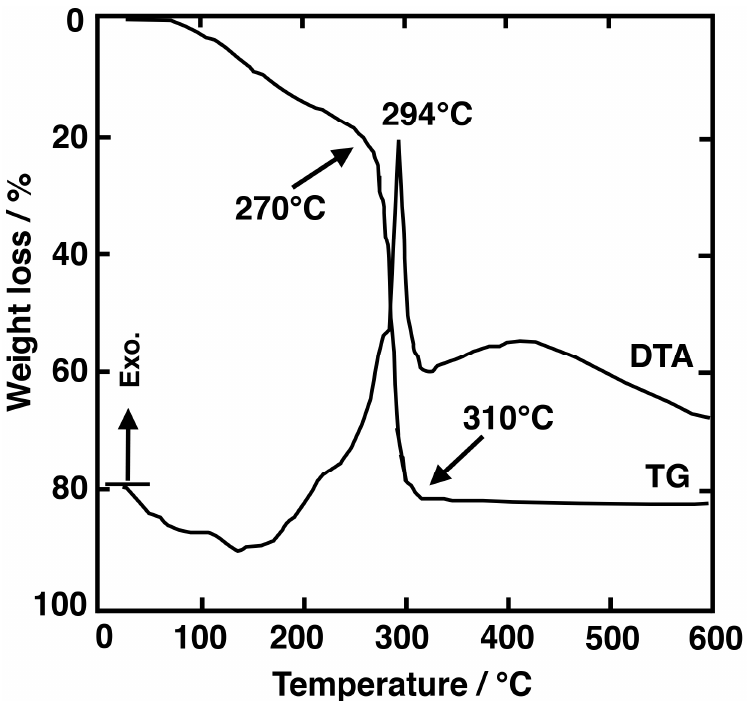
Figure 1. TGA/DTA curve of the MgF 2 gel obtained by drying the sol at 80 °C. Figure modified from Figure 4 of [22].